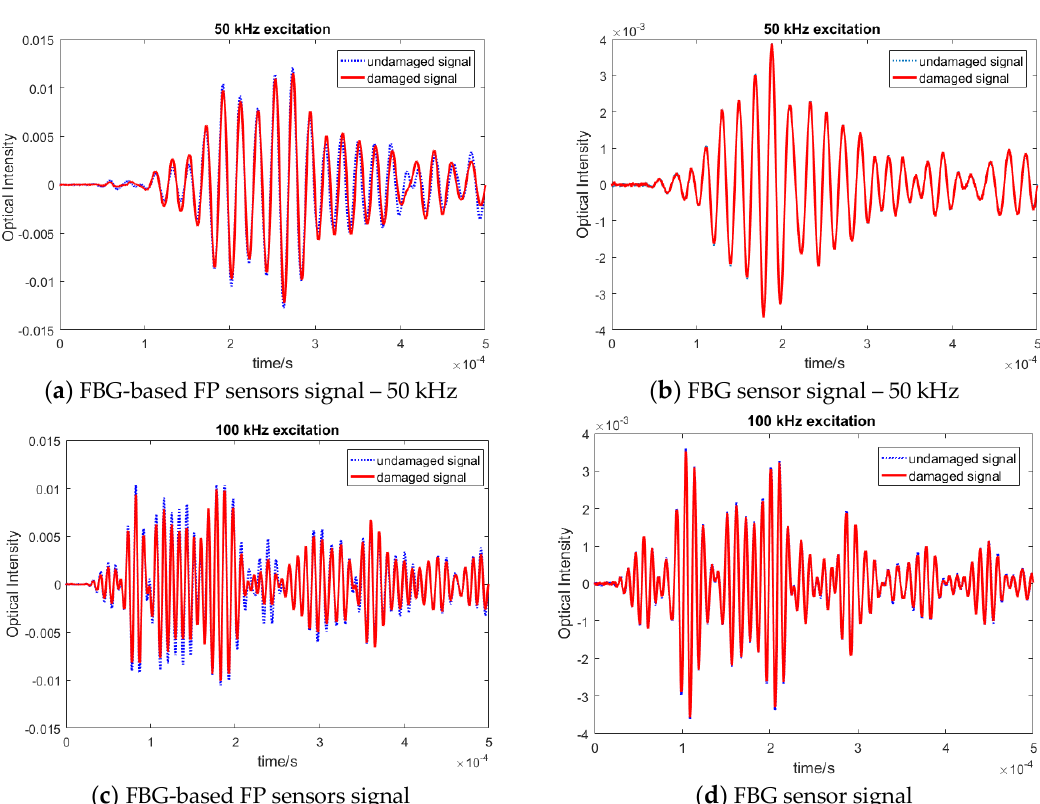
Figure 17. Comparison of damage signals recorded by ( a ), ( c ) FBG-based FP and ( b ), ( d ) FBG sensors.